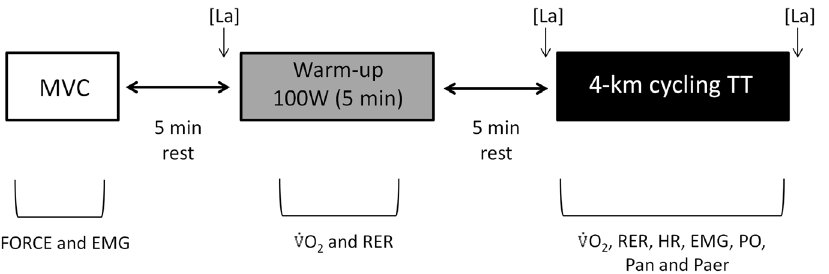
Figure 1. Experimental Protocol. [La]: plasma lactate concentrations; MVC: maximal voluntary contraction; EMG: electromyographic activity; VO 2 : oxygen uptake; RER: respiratory exchange ratio; HR: heart rate; PPO: power output; Paer: aerobic mechanical power output; Pan: anaerobic mechanical power output.